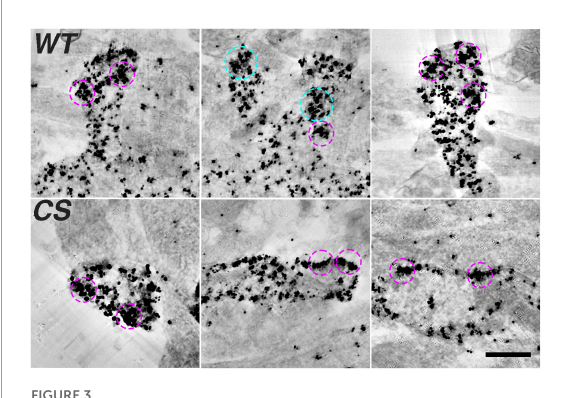
FIGURE3 Densely labeled AKAP150 gold clusters at spine synapses revealed by thick section STEM tomography (Top row, WT; Bottom row, CS). Projection views of 50 averaged consecutive virtual sections (222 nm) of AKAP150 labeled dendritic spines showing ∼ 200 nm dense gold clusters enclosed by magenta circles (inner diameter 240 nm) and ∼ 300 nm dense gold clusters enclosed by cyan circles (inner diameter 336 nm). Many dense gold clusters are located next to extra synaptic membrane, some clusters were at the PSD, some in the cytoplasm. Scale bar 500